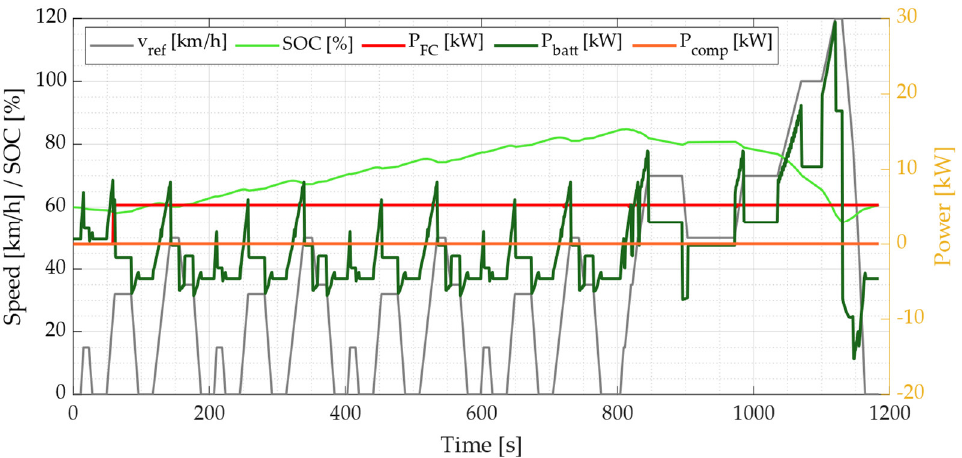
Figure 9. Simulation conducted on NEDC driving cycle with constant power control strategy.